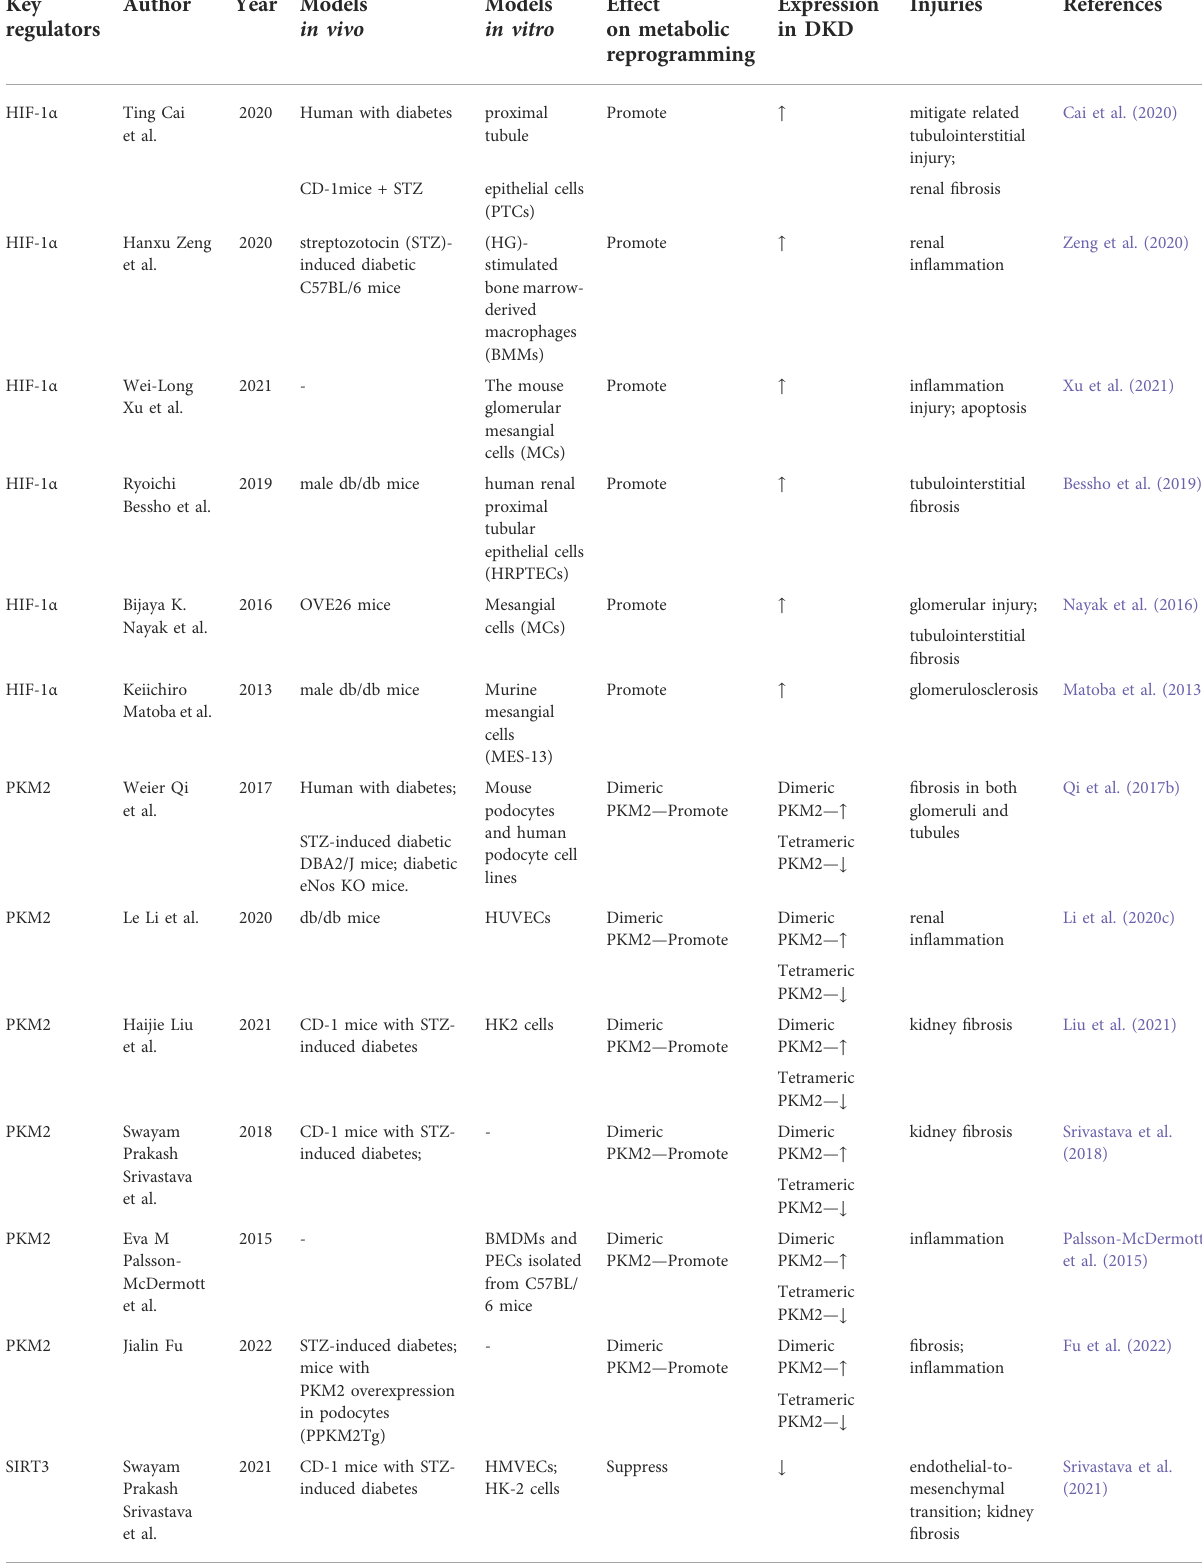
TABLE 1 Molecular regulators of metabolic reprogramming in